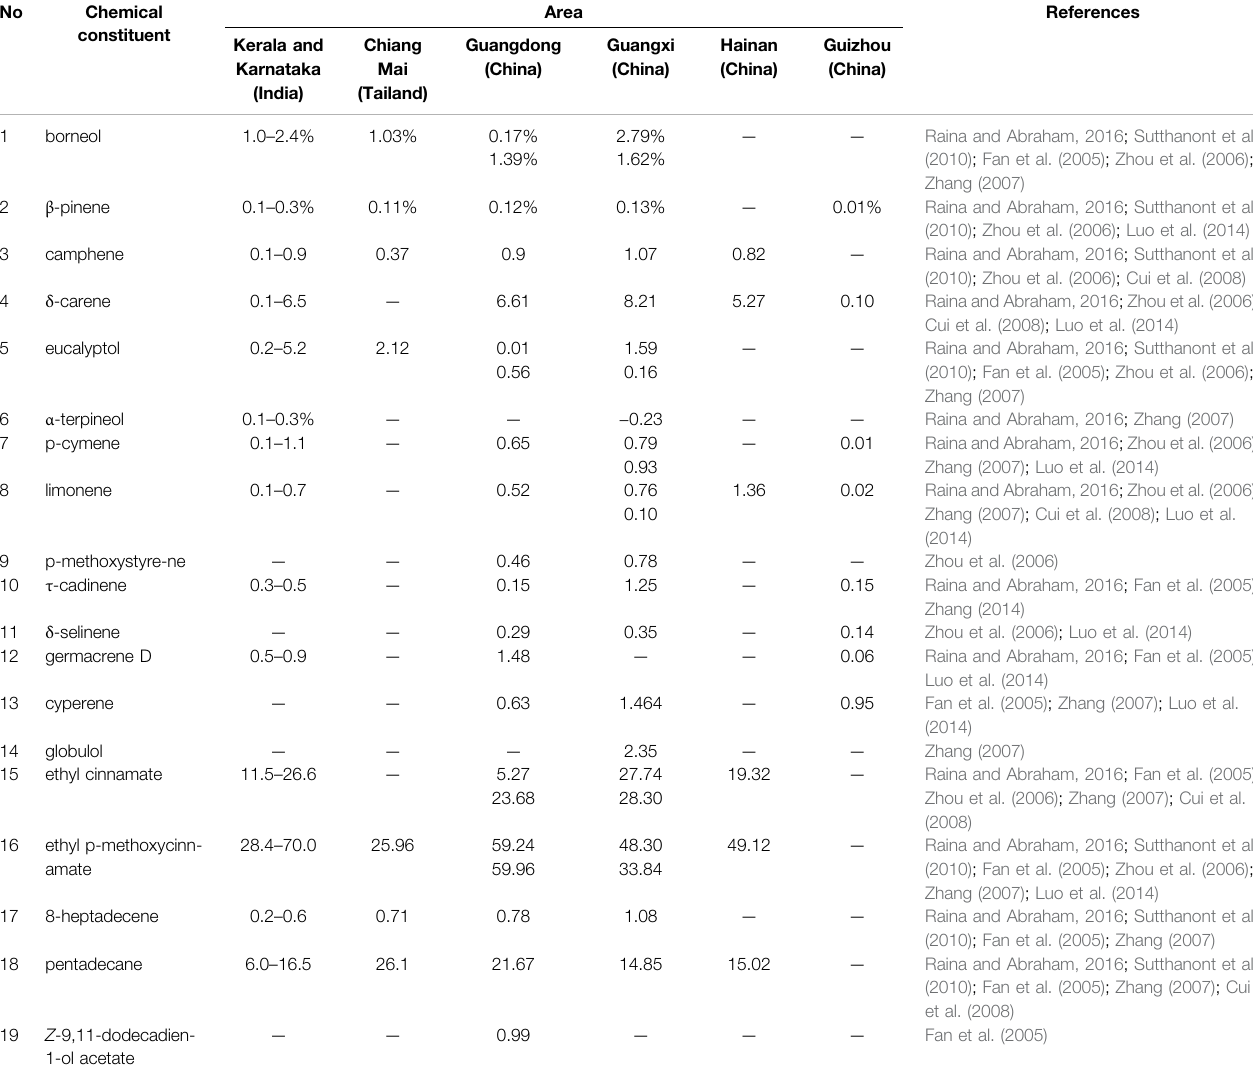
TABLE 4 | Major compounds of essential oils of K.